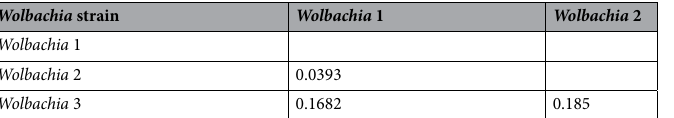
Table 2. Mean genetic distance of the three genetic strains of Wolbachia detected in Erebia pronoe based on the WSP gene fragment.